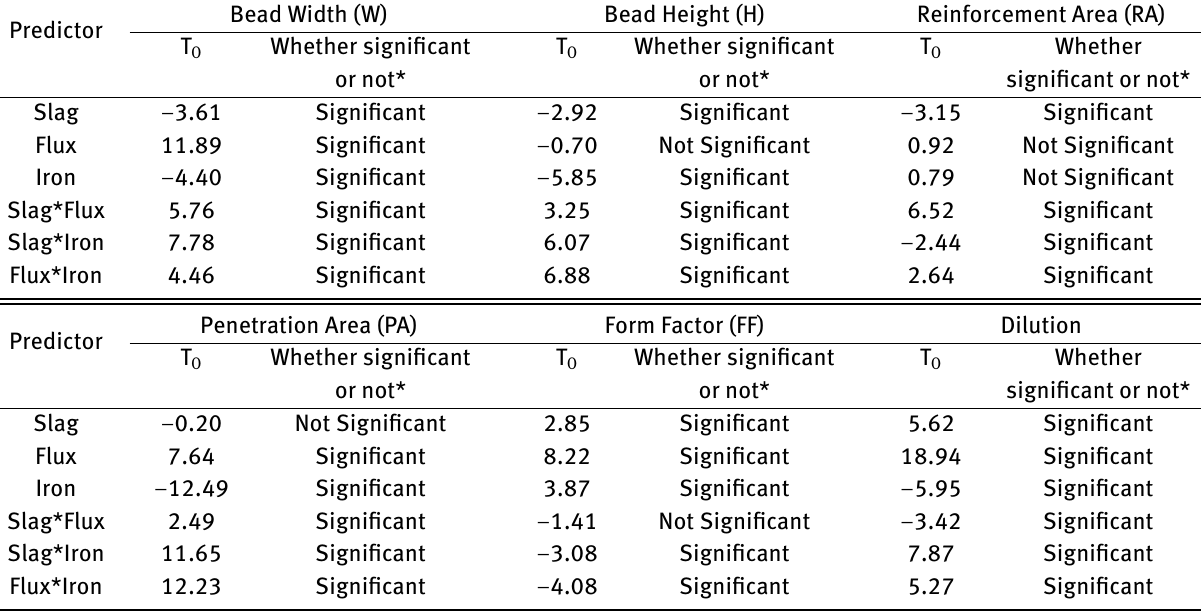
Table A1: Significance testing of SQM for weld geometry characteristics